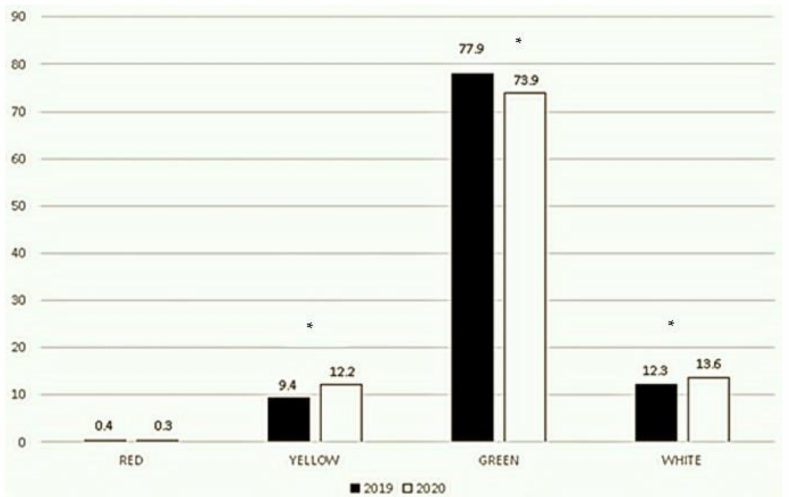
Figure 4. Triage categories in September–November, 2019 and 2020. This figure shows the breakdown of 100% of ER visits into 4 codes. * p <